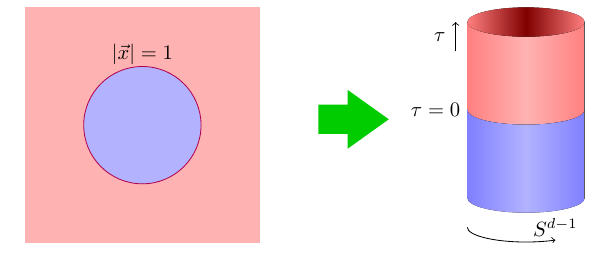
Figure 1 . A map from R d to R